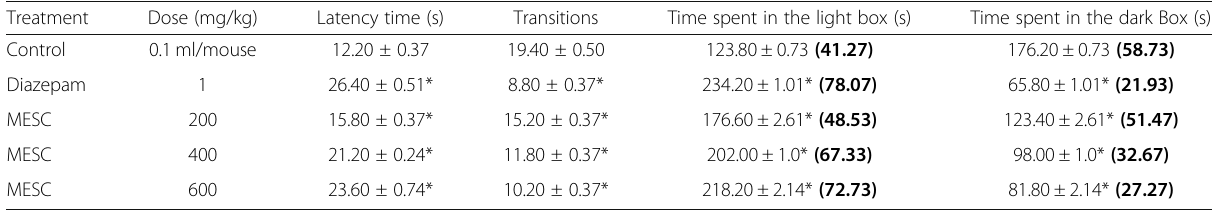
Table 5 The anxiolytic effect of MESC on light-dark box test in mice Treatment Dose (mg/kg) Latency time (s) Transitions Time spent in the light box (s) Time spent in the dark Box (s)